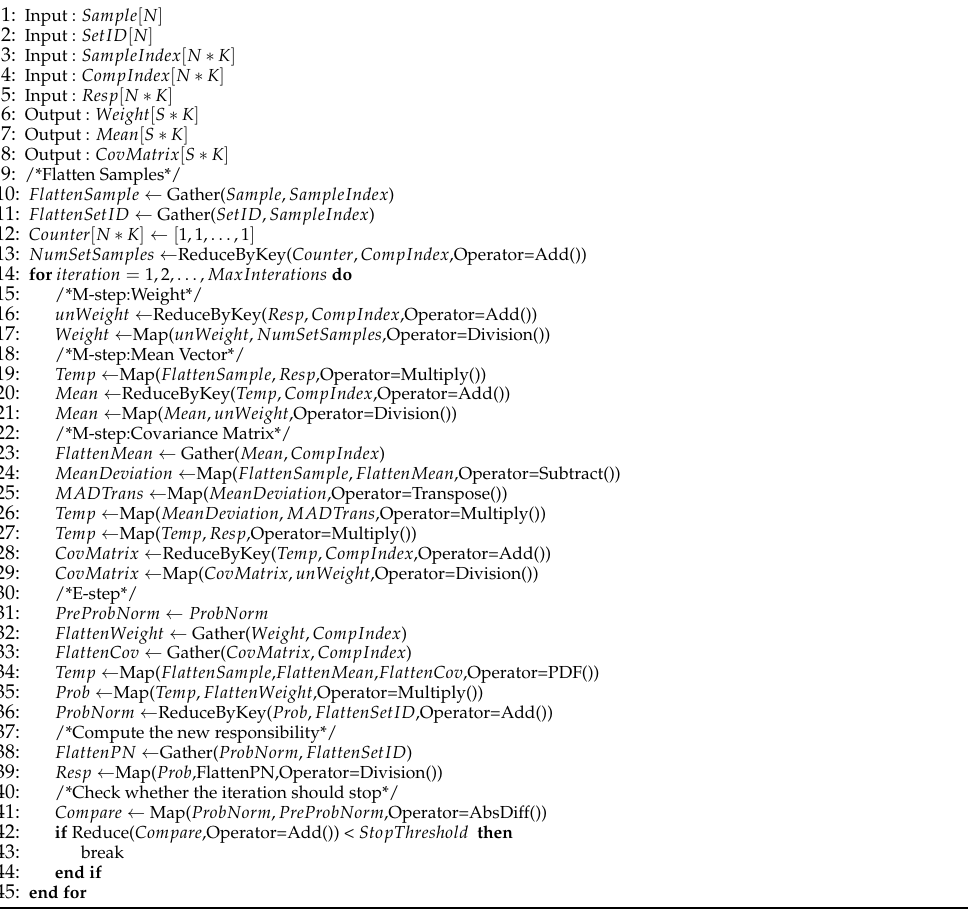
Algorithm 4 DPP Version of the Multi-set EM